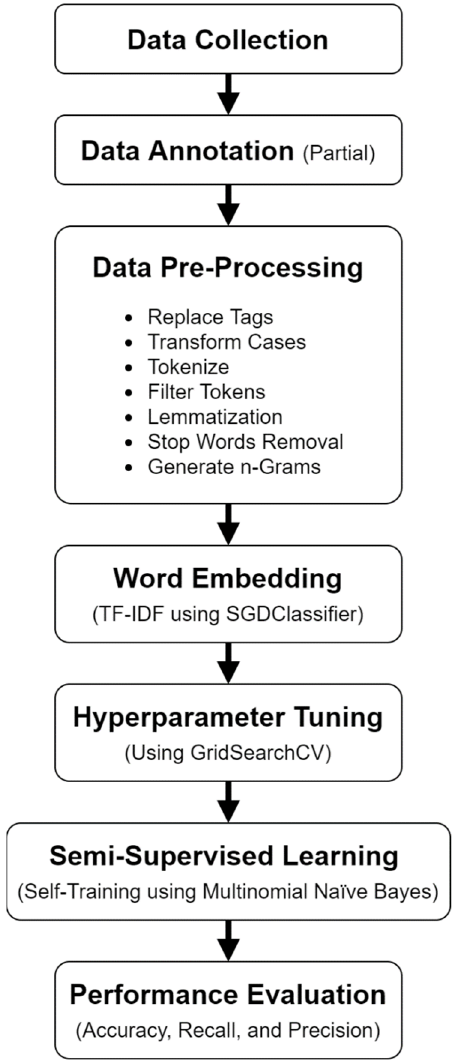
Figure 1. Eight Phases of the Study: Data Collection, Data Annotation, Data Pre-Processing, Word Embedding, Hyperparameter Tuning, Comparative Analysis, Semi-Supervised Learning, and Performance Evaluation.